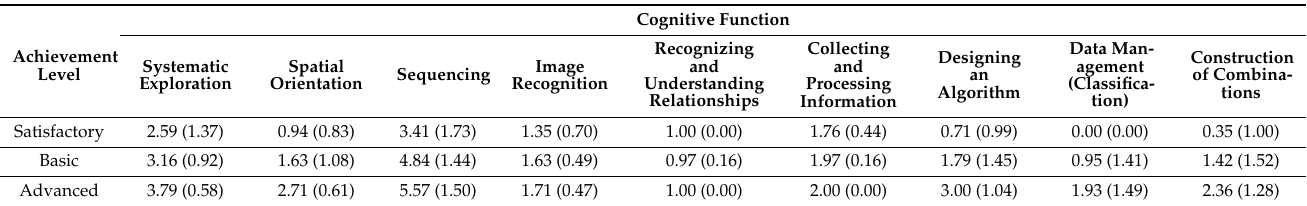
Table 2. Assessment results for the diagnostic test of cognitive abilities by level of achievement (average (standard